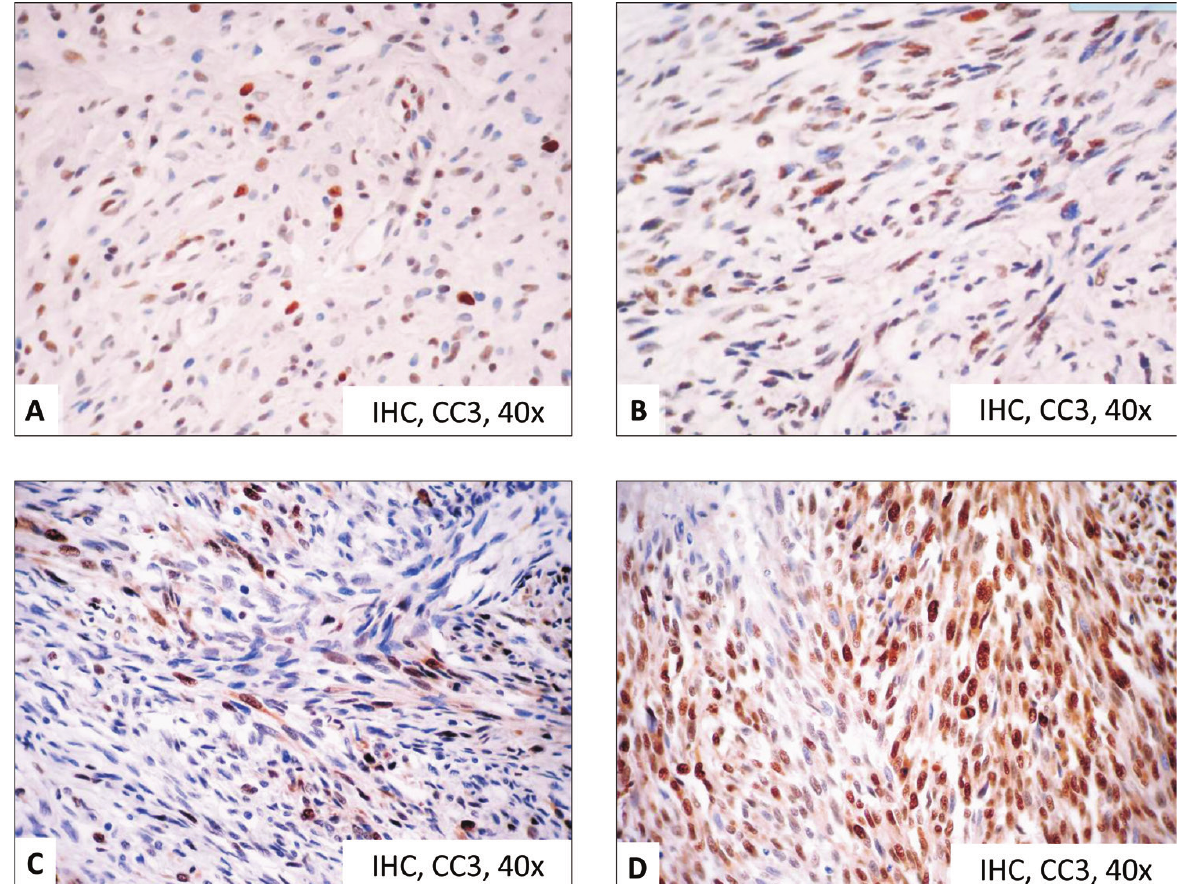
Fig. 2 - A. Neurofibroma showing nuclear immunostaining for CC3. B. MPNST showing nuclear immunostaining for CC3. C and D. MPNST showing nuclear and cytoplasmic immunostaining for